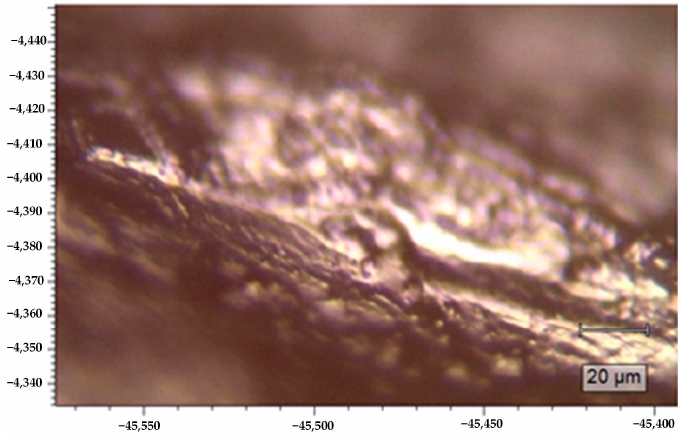
Figure 4. A tissue image on the Raman spectrometer camera screen.